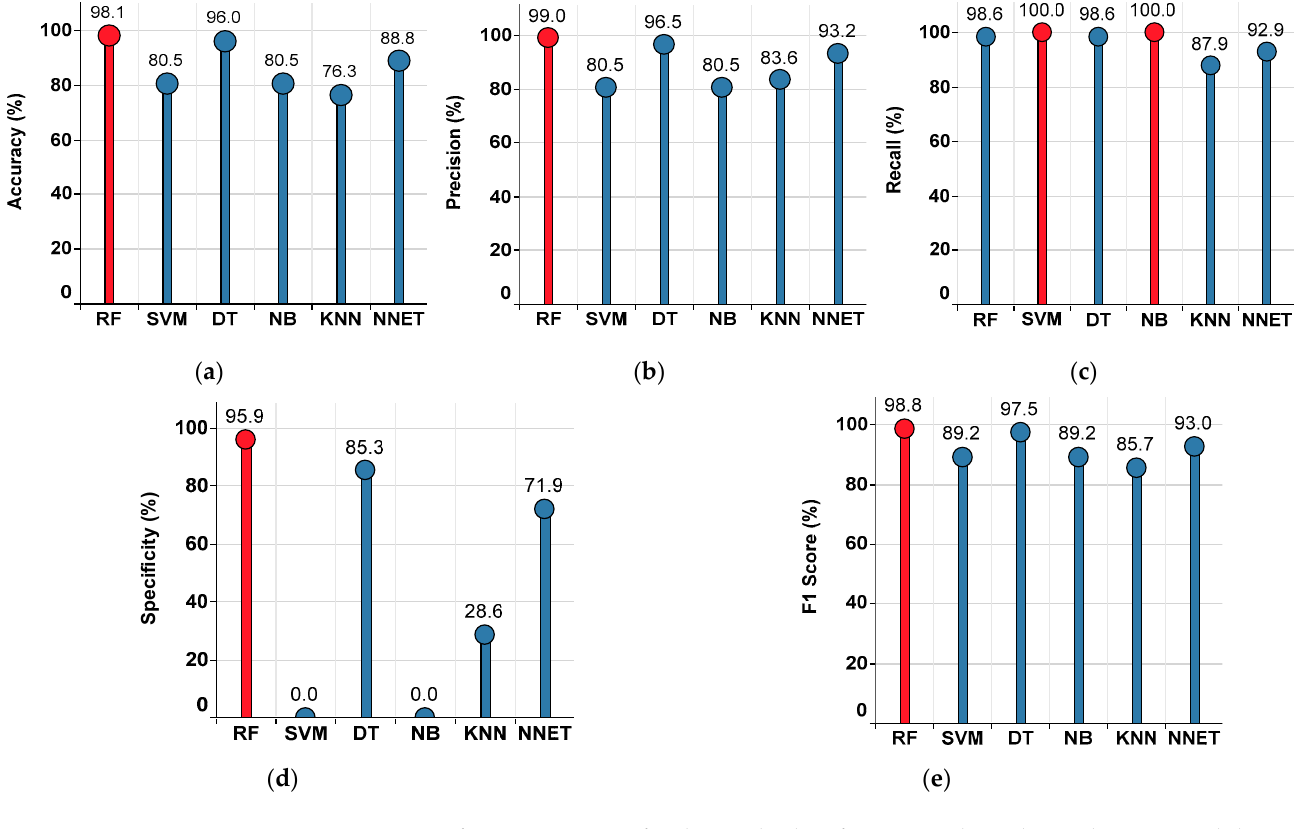
Figure 7. Performance metrics for the single-classifier approach on the median imputed dataset. ( a ) Accuracy ( b ) Precision. ( c ) Recall. ( d ) Specificity. ( e ) F1 Score.